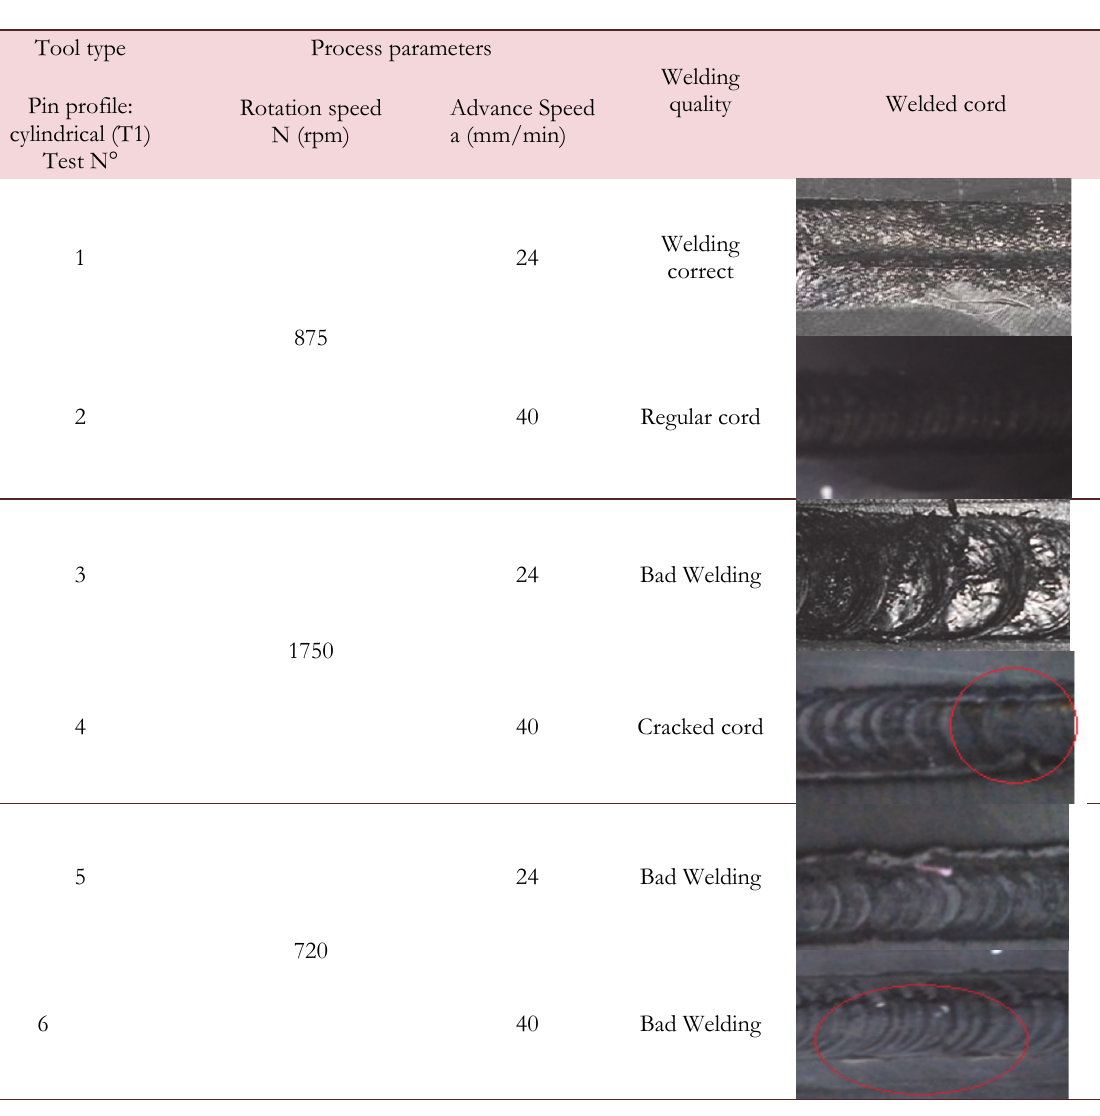
Table 3a: Welding process